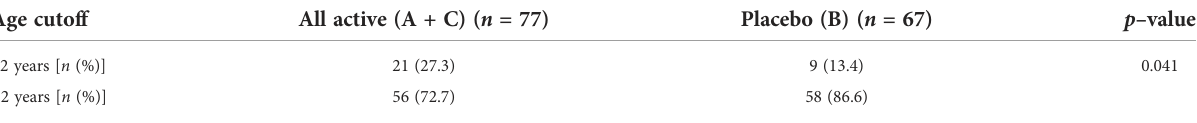
TABLE 3 Number and percentage of patients <2 or ≥ 2 years of age with stool samples and gut microbiota analysis done at T0 ( n = 144). Age cutoff All active (A + C) ( n =